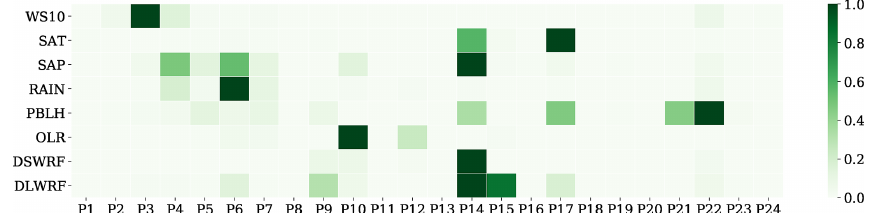
Figure 10. Heatmap of the total sensitivity index of 24 parameters for the meteorological variables considered, with the Sobol’ sensitivity analysis.